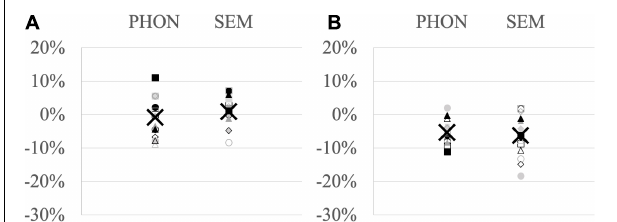
FIGURE 1 | Proportion of (A) accuracy differences and (B) RT differences between related and unrelated conditions in each participant (dots, squares, diamonds, triangles) and group mean (X) for the phonological cueing paradigm (PHON – left row) and semantic cueing paradigm (SEM – right row); negative values indicate facilitation after related cues and positive values